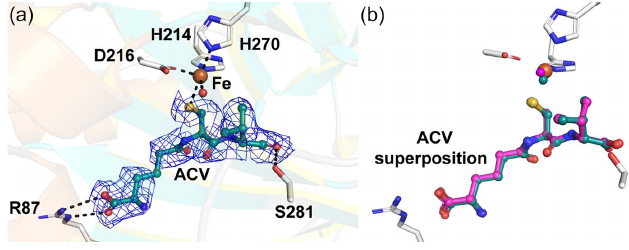
Figure 6 Structural comparison of anaerobic IPNS structures collected with RT serial fixed-target methods and under cryogenic conditions. ( a ) Composite omit map of IPNS:Fe:ACV displayed at 1.0 (cid:5) contour level to 2.2 A ˚ resolution, carved around the ACV substrate (PDB entry 6y0o). The ACVand residues R87, S281 and the Fe are shown as balls and sticks. ( b ) Superimposition of the cryogenic (magenta, PDB entry 1bk0) and serial RT (cyan, PDB entry 6y0o, this study) IPNS:Fe:ACV complex structures. The comparison reveals no differences in the conformation of the ACV substrate, with minor differences in the position of the metal- coordinating